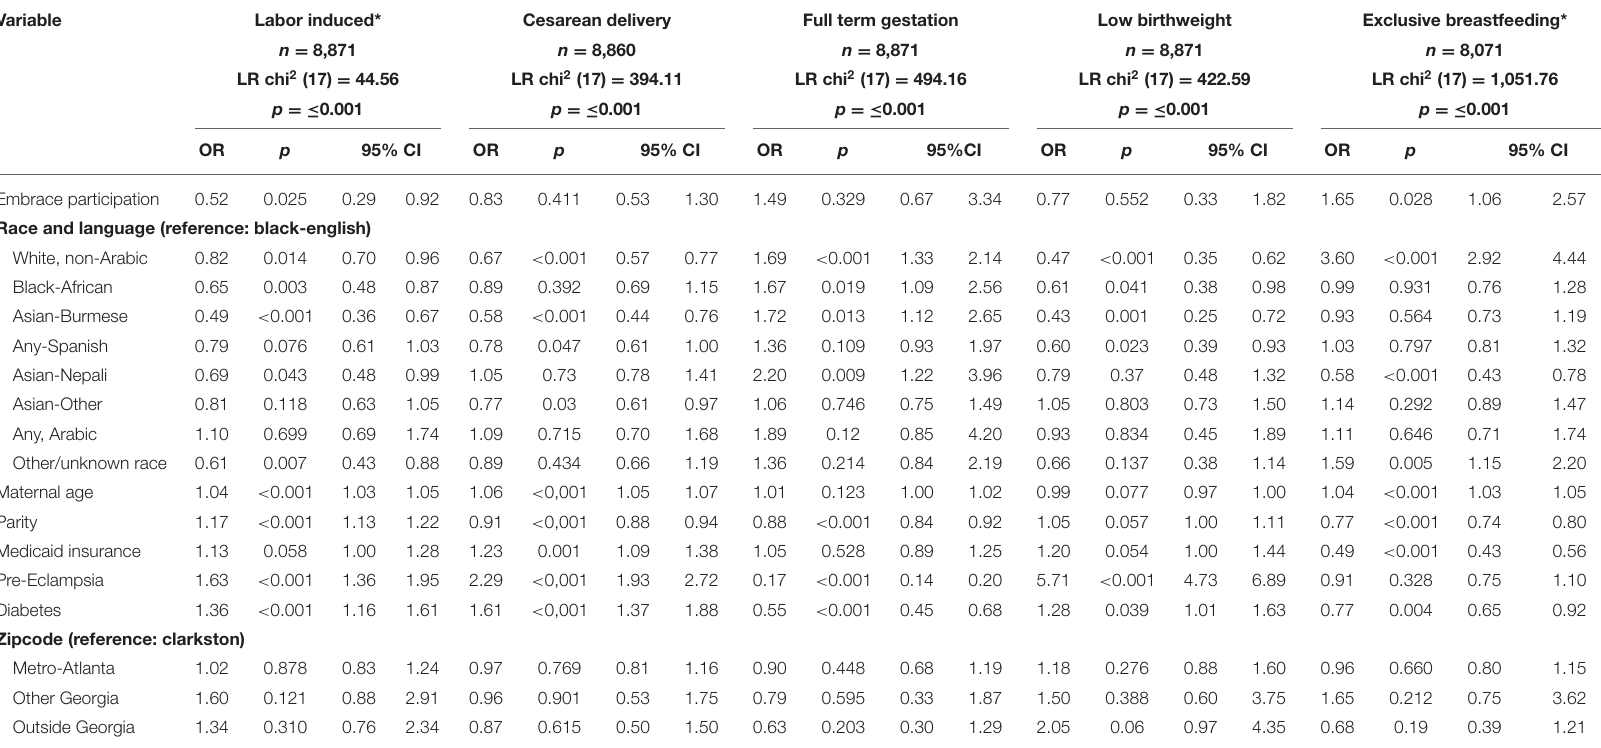
TABLE 3 | Multivariate analyses of pregnancy-related outcomes for the Embrace participants and the comparison group at Emory Decatur Hospital from 2016 to 2018.